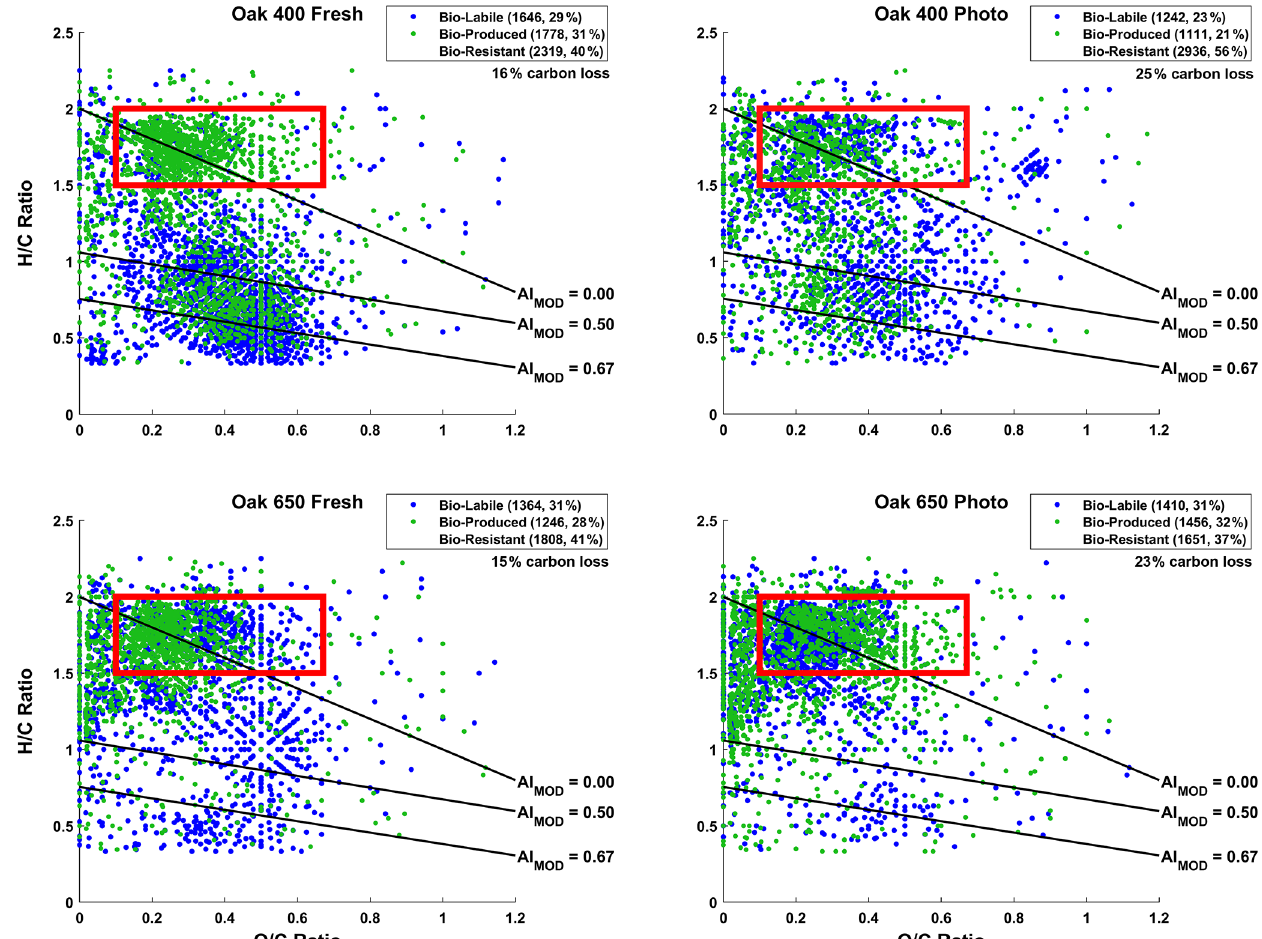
Figure 1. Van Krevelen (vK) diagrams of 10d microbially incubated pyDOM leachates. Formulas are classified as bio-labile (formulas only found in the control pyDOM leachates) and bio-produced (formulas only found in the bio-incubated samples). Formulas that are present in both the control and bio-incubated samples are operationally classified as bio-resistant and not shown for clarity. These three classes of molecules are separately plotted on vK diagrams and shown in Sect. S2 of the Supplement (Figs. S2–S4). The number of formulas in each of these pools is shown in the legends along with corresponding percentages (relative to total number of formulas in the two samples being compared). The carbon losses quantified by Bostick et al. (2021) are listed under the legends. The black lines indicate modified aromaticity index cutoffs (AI MOD ; Koch and Dittmar, 2006, 2016), and the red box indicates the peptide region (valid only for N-containing